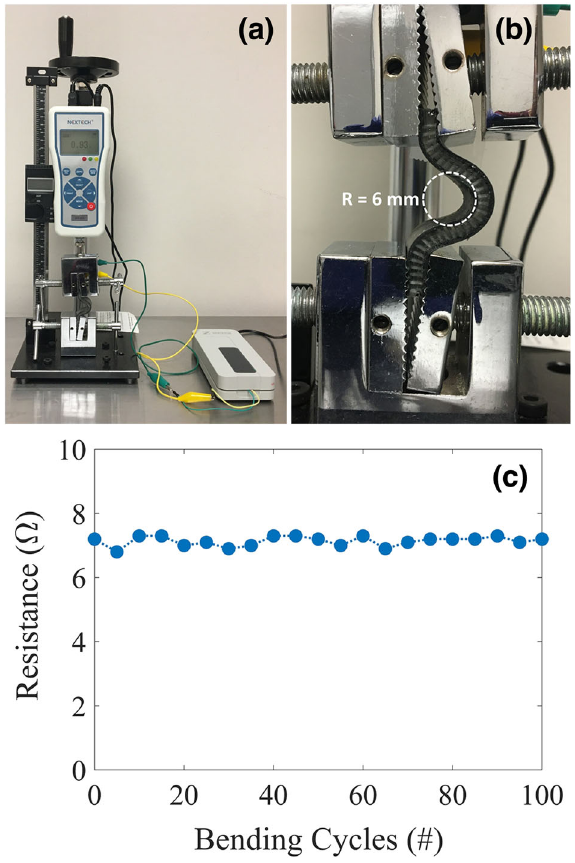
Fig. 7 Flexible TEG electrical resistance. a Measurement setup used to measure the AC electrical resistance of a TEG while it is being fl exed with a known force, b A closeup image showing the fl exed TEG, c Electrical resistance measured after repetitive bending cycles. Each data point corresponds to the AC resistance measured after fi ve bending cycles.